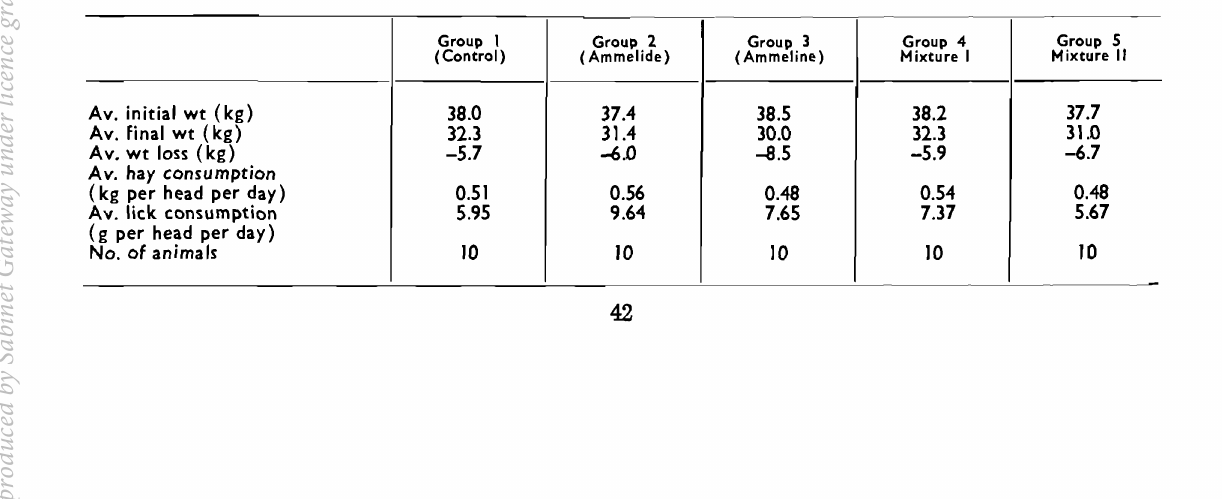
TABLE 4: L1VEWEIGHT AND FEED INTAKE OF SHEEP OVER 28